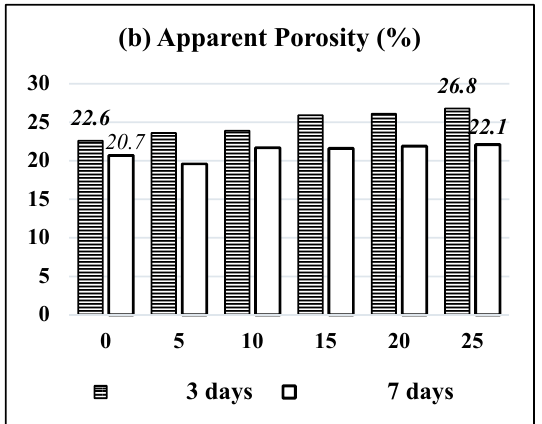
Figure 4. HT–BA blended OPC-mortar samples; ( a ) Water absorption after 3 and 7 days of curing, ( b ) Apparent porosity after 3 and 7 days of curing.